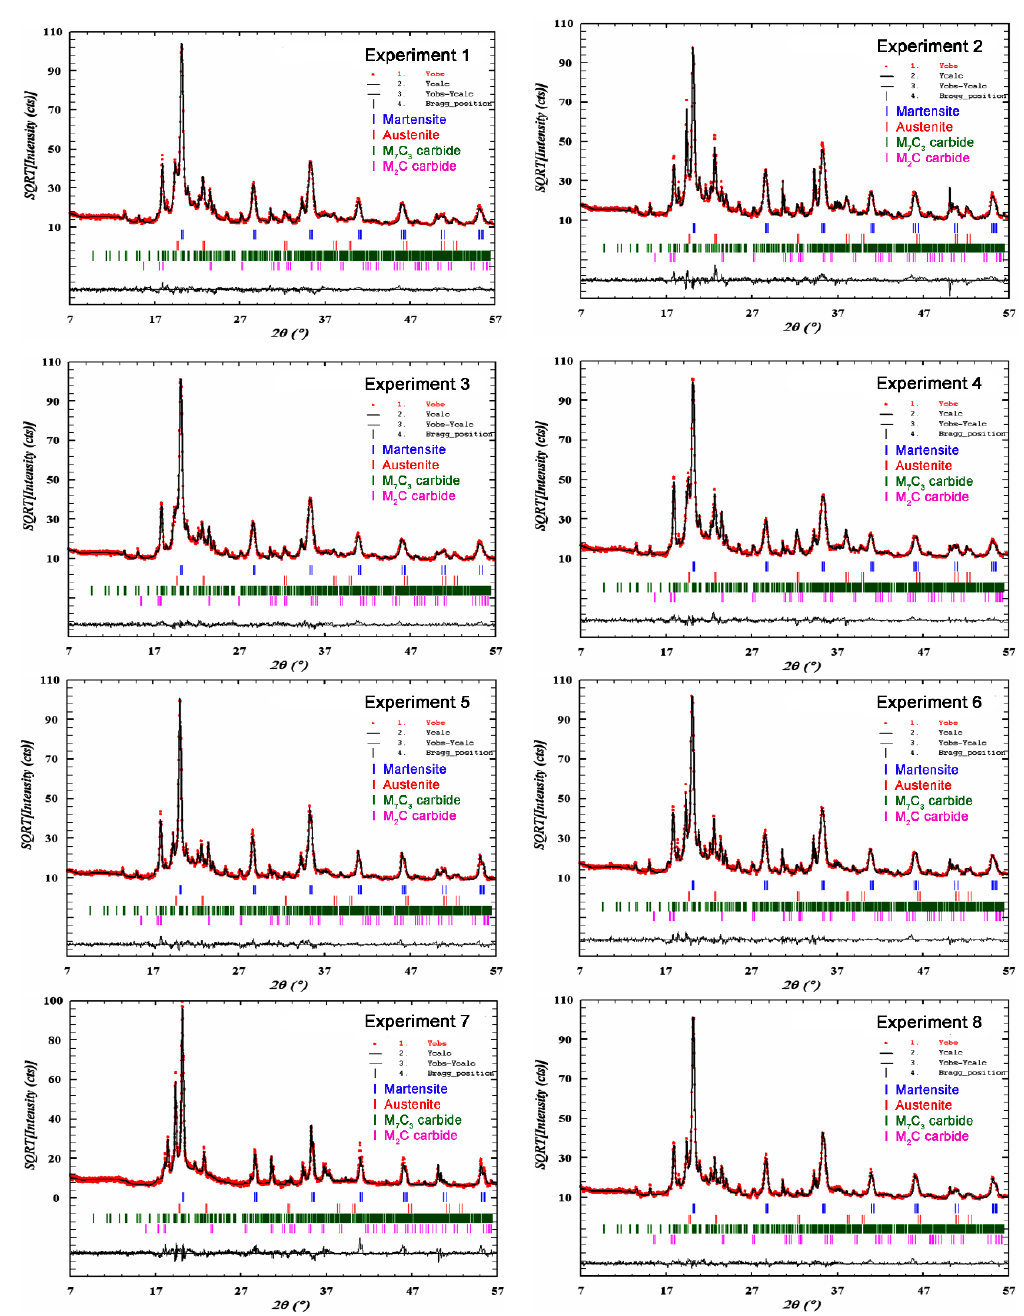
Figure 1. Diffractograms of the experiments after Rietveld refinement.